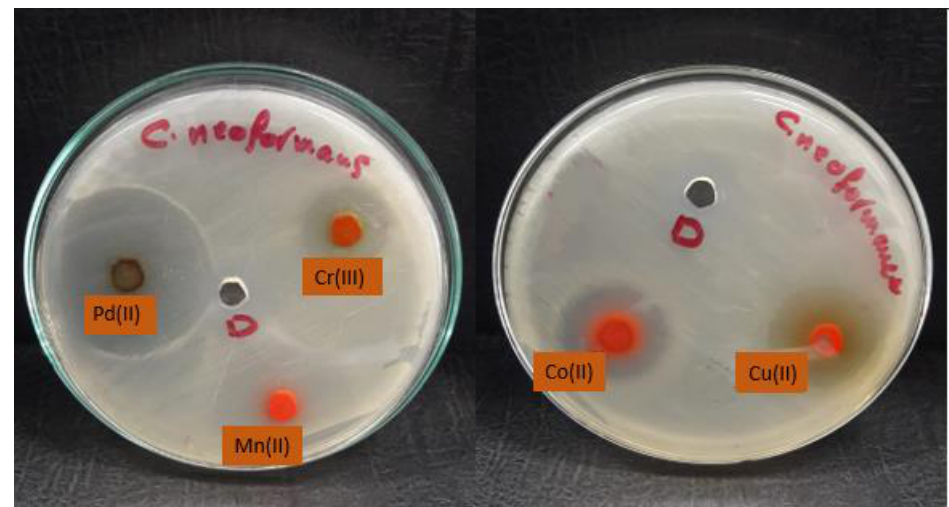
Figure 11. Antifungal activities of the Ketoconazole and five metal complexes.